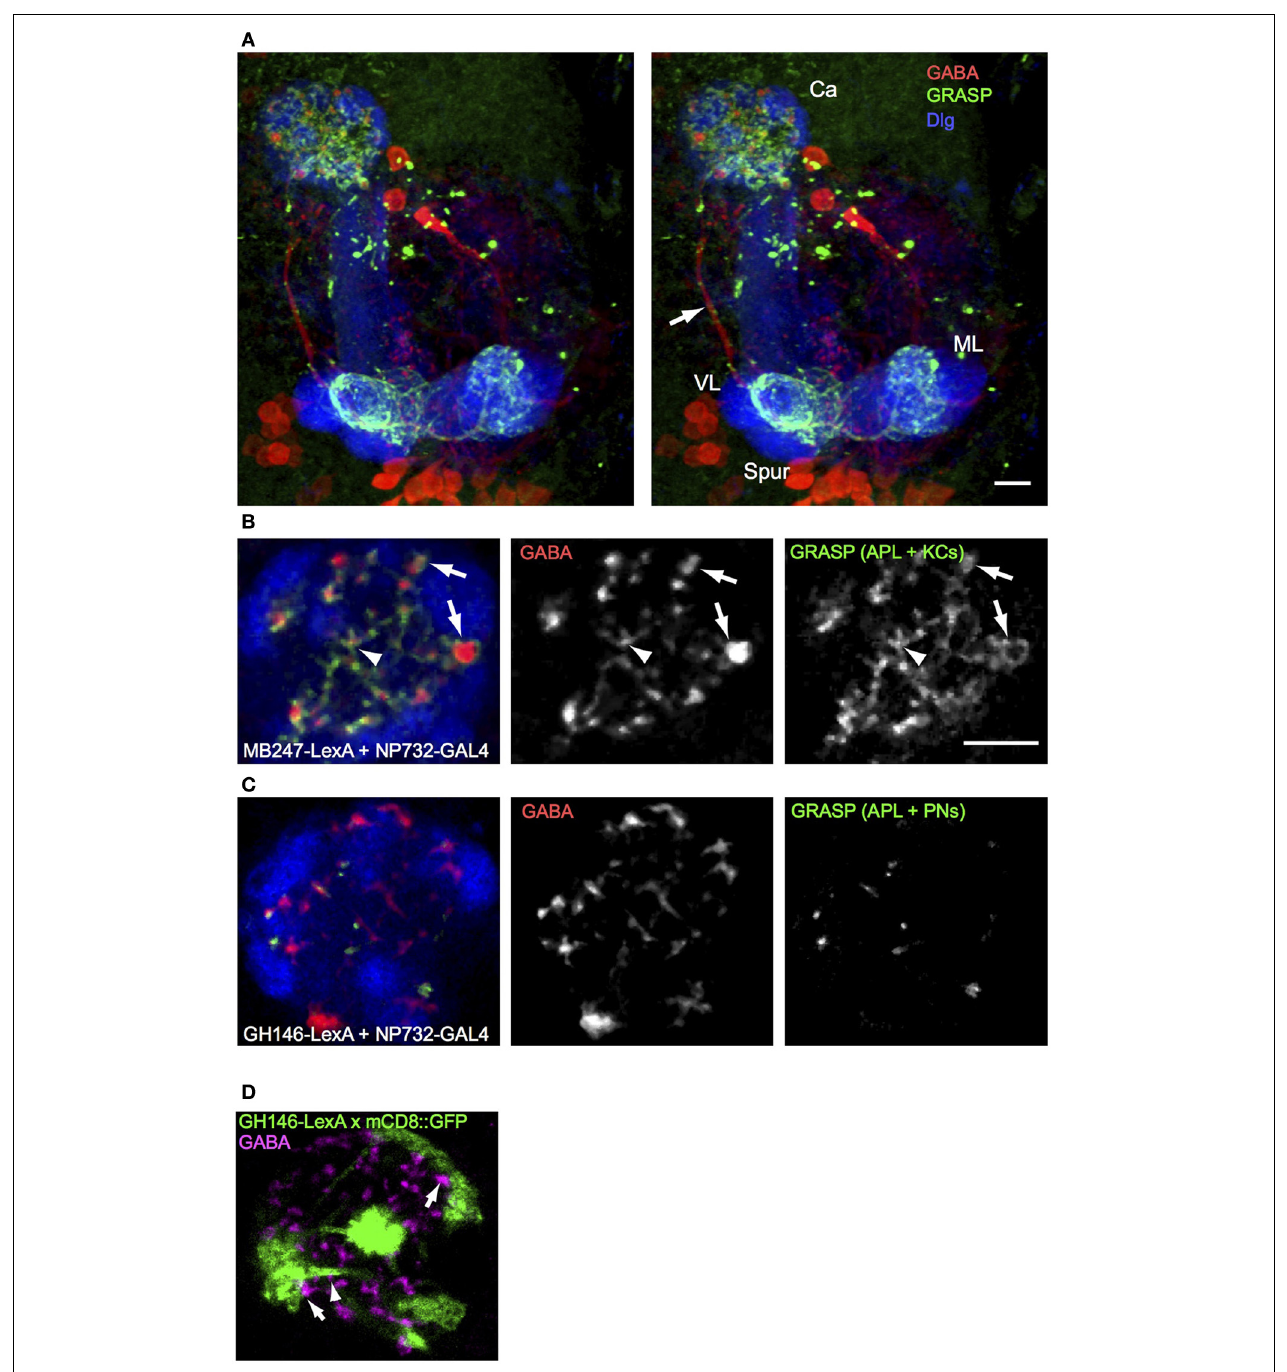
FIGURE 3 | GRASP shows extensive contacts of larval APL with KCs in MB calyx and lobes, and few contacts with PNs. (A) An anterior stereo view of a larval brain expressing MB247-LexA , NP0732-GAL4 , and the two GRASP constructs UAS-CD4::spGFP1-10 and LexAop-CD4::spGFP11 , labeled with anti-GABA (red), anti-GFP (green) and anti-Dlg (blue). Reconstituted GFP signal is present only in calyx and lobe projections (labels as in Figures 1 , 2 ) of the larval APL and is absent from the main larval APL neurite (arrow). (B) A section through the calyx of a similar larva, showing widespread GRASP signal between larval APL and KCs,